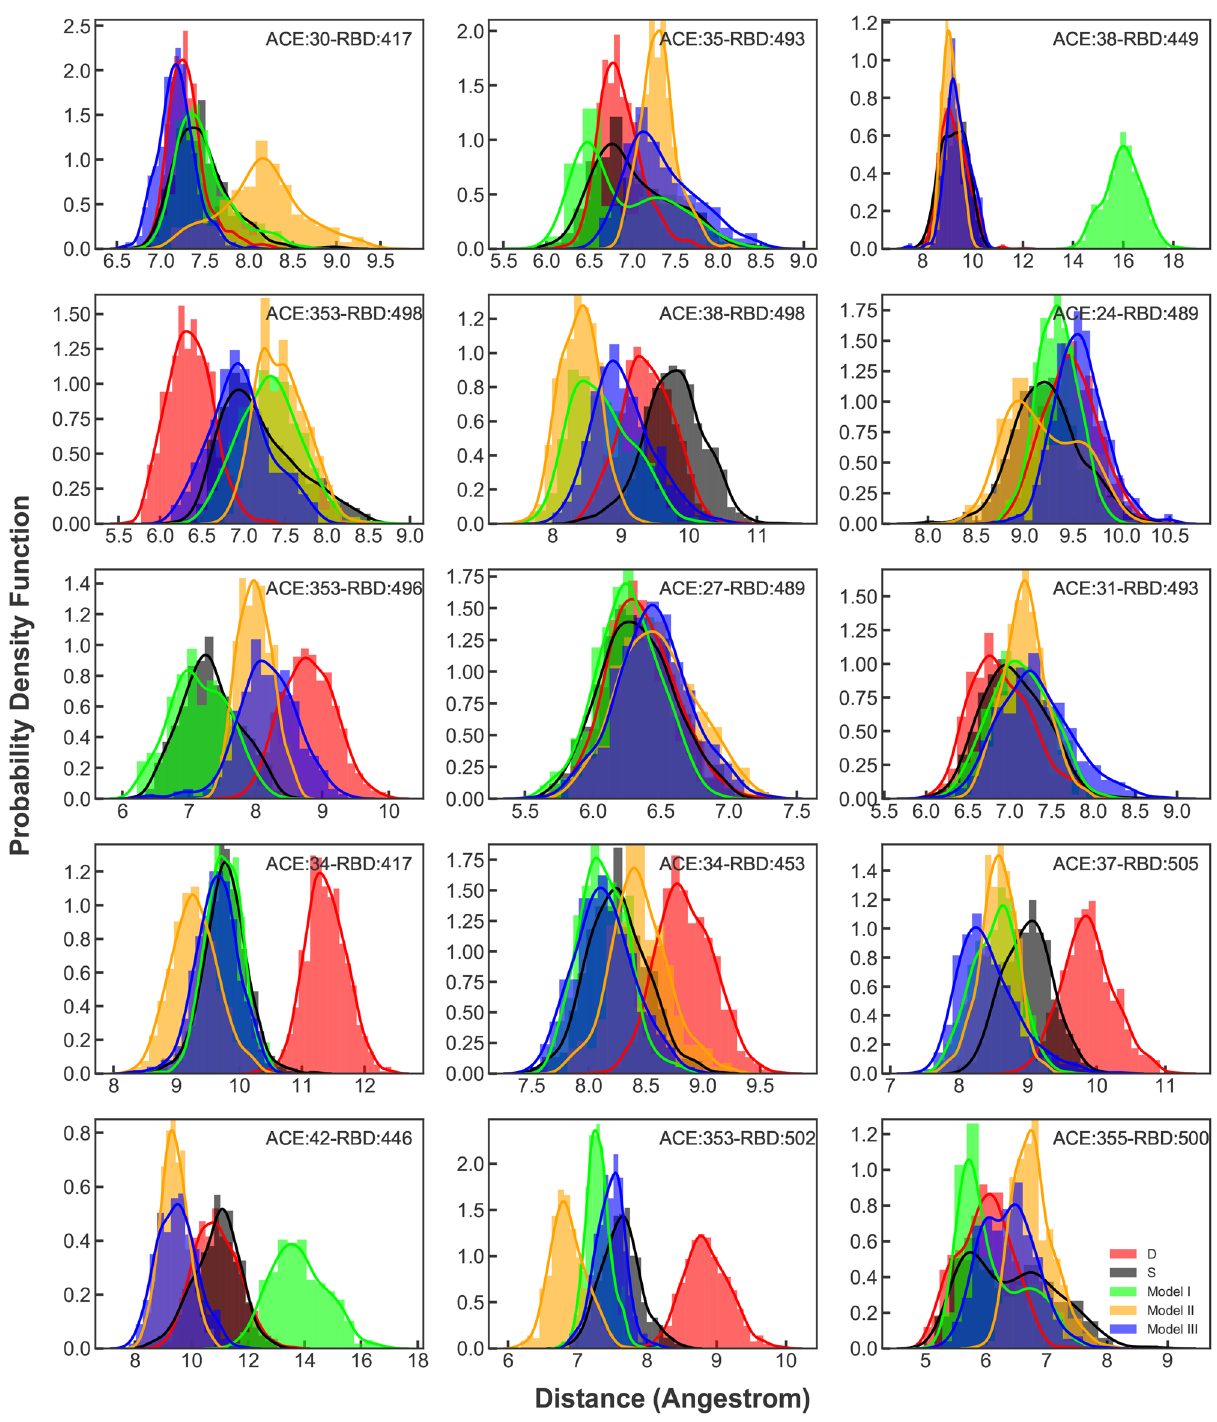
Figure 10. PDF of RBD-ACE2 interface interacting pairs averaged distance distribution with a histogram and maximum likelihood gaussian distribution fit: calculated from all replicate of each system and are represented in black, lime, orange and blue for models S and I–III respectively. PDFs of model D is shown in